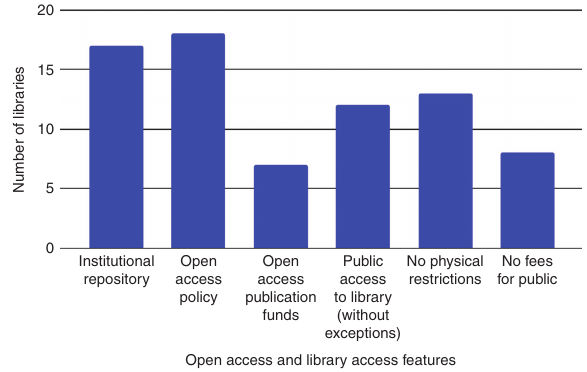
Fig. 4: Open access and library access features present at each